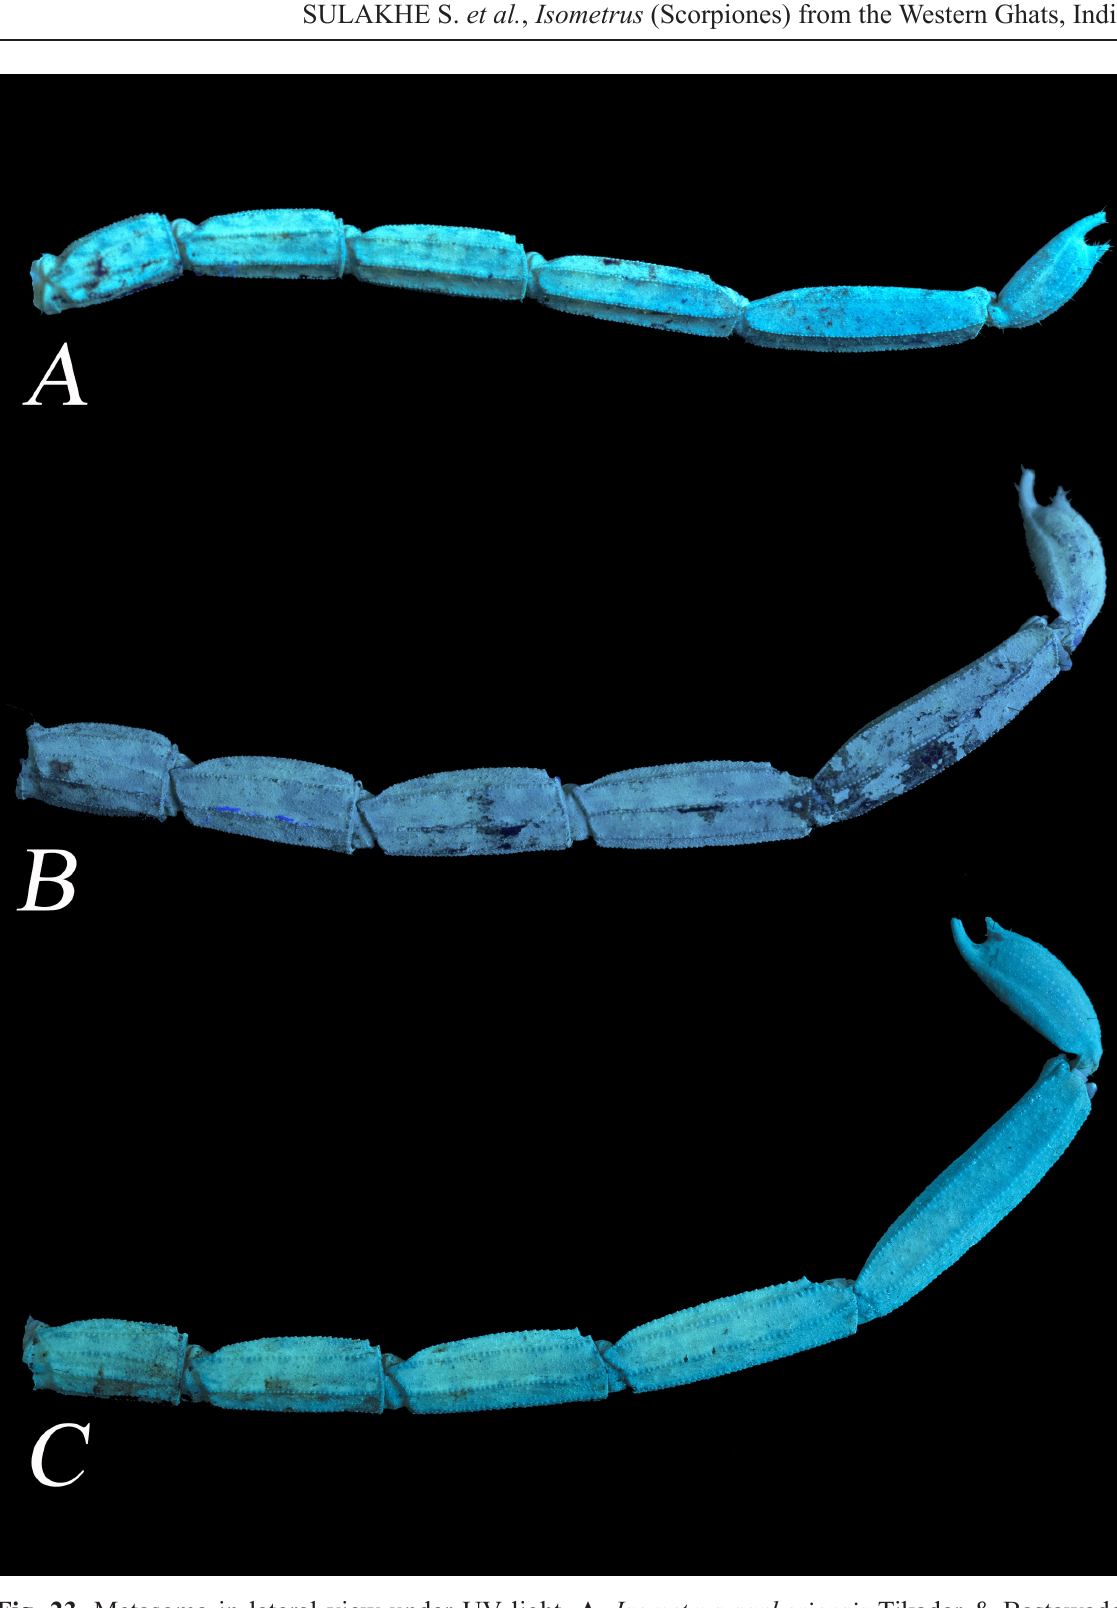
Fig. 23. Metasoma in lateral view under UV light. A . Isometrus sankeriensis Tikader & Bastawade, 1983, neotype, adult ♂ (BNHS SC 194). B . I. nakshatra sp. nov., holotype, adult ♂ (BNHS SC